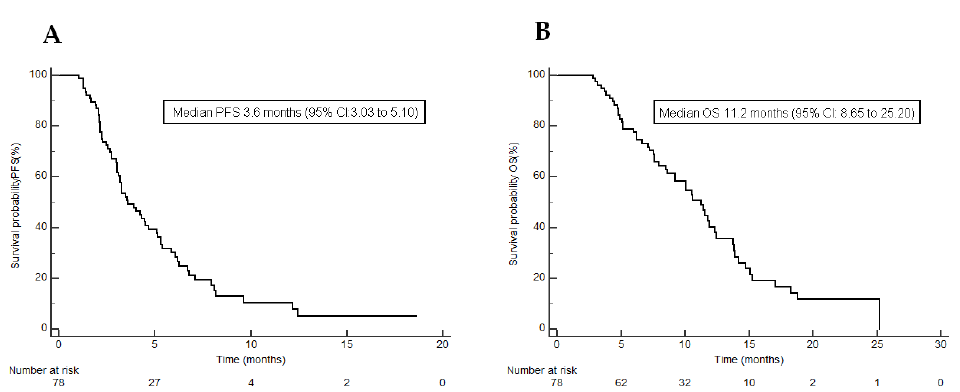
Figure 2. Kaplan–Meier curves showing ( A ) progression-free survival under trifluridine/tipiracil; ( B ) overall survival under trifluridine/tipiracil.